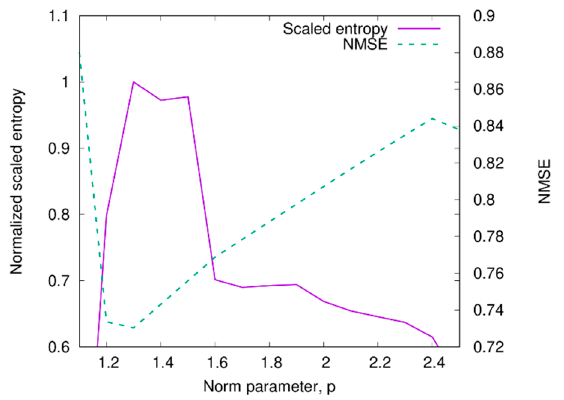
Figure 6. Reconstructed distribution of the relative dielectric permittivity inside the TW investigation domain. Two dielectric cylinders. ( a ) Optimal value of the norm parameter ( 𝑝 (cid:3042)(cid:3043)(cid:3047) = 1.3 ) and ( b ) standard Hilbert-space approach ( 𝑝 = 2 ).